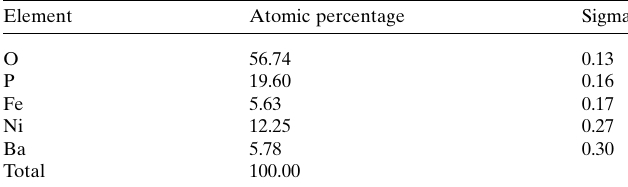
Table 2 Atom percentages in BaNi 2 Fe(PO 4 ) 3 as determined by EDS.